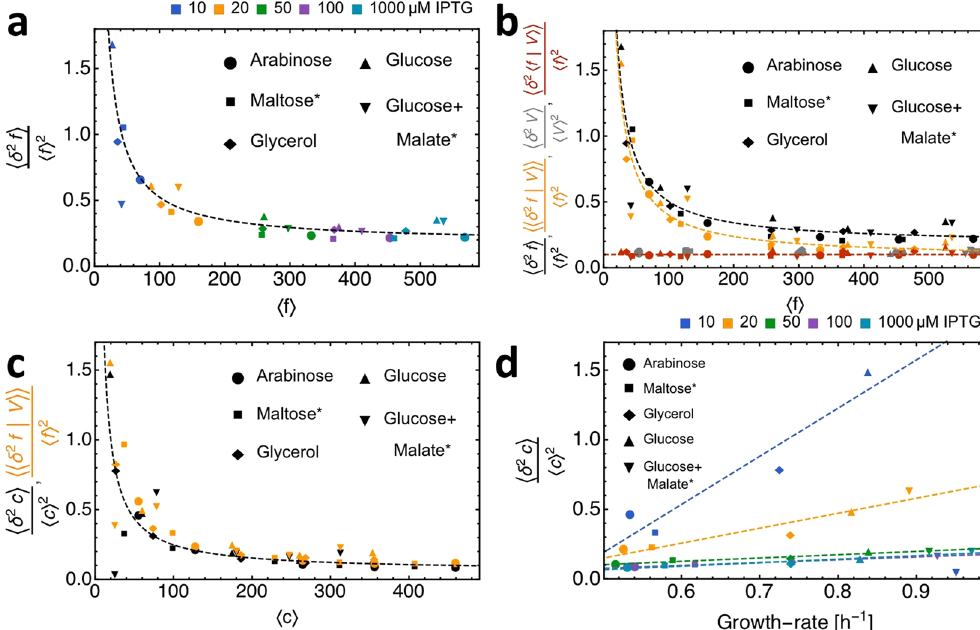
Figure 4. Effects of promoter activity and growth rate on noise are indistinguishable and fall on an invariant relation between noise and mean of protein expression. ( a ) Noise in total cell fluorescence as function of mean total cell fluorescence across growth rates and promoter activities. ( b ) Decomposition of noise in total cell 2 fluorescence into its intrinsic, ‘biochemical’ contribution, δ f V , and its extrinsic, ‘volume-variation’ 2 f 2 contribution, δ f V . At balanced growth = δ , indicating that fluorescence variation scales with 2 2 f volume variation per cell, which is indeed evident from our experimental data. ( c ) Noise in fluorescence concentration per cell is shown as function of the mean concentration. At balanced growth, the following equality holds = = δ , which indicates that protein expression noise due to biochemical origins is directly captured by noise in fluorescence concentration. ( a – c ) Dashed lines are fits of the form 2 a . ( d ) Dependence of noise in fluorescence concentration on the cellular growth rate at different = + δ b x 2 x x magnitudes of promoter activity. The changes in fluorescence concentration noise can be explained by the decreasing mean expression, through dilution by volume-growth. Dashed lines are linear fits to guide the eye. For each carbon source, data points from 10 to 1000 μ M IPTG are shown. Carbon sources with asterisks indicate single experiments, all other data points are the average of two biological replicates. Plots with all individual replicates are shown in Fig. S16, in the Supplementary